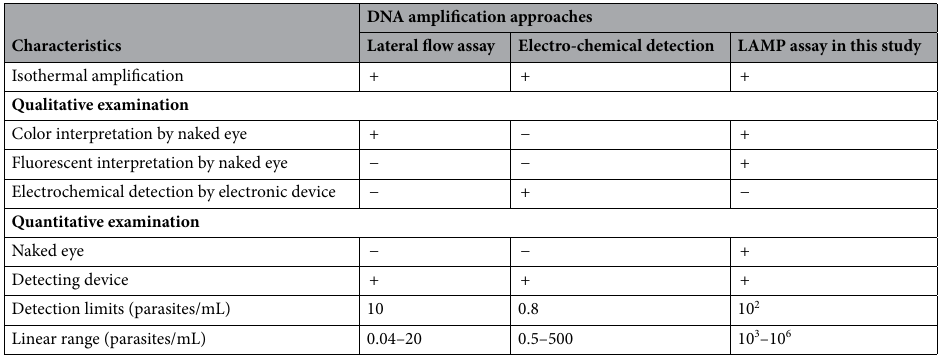
Table 2. The characteristics comparison of different DNA amplification approaches between LAMP assay in this study, lateral flow assay 35 and electrochemical detection 34 for detecting Leishmania DNA in human and animal,